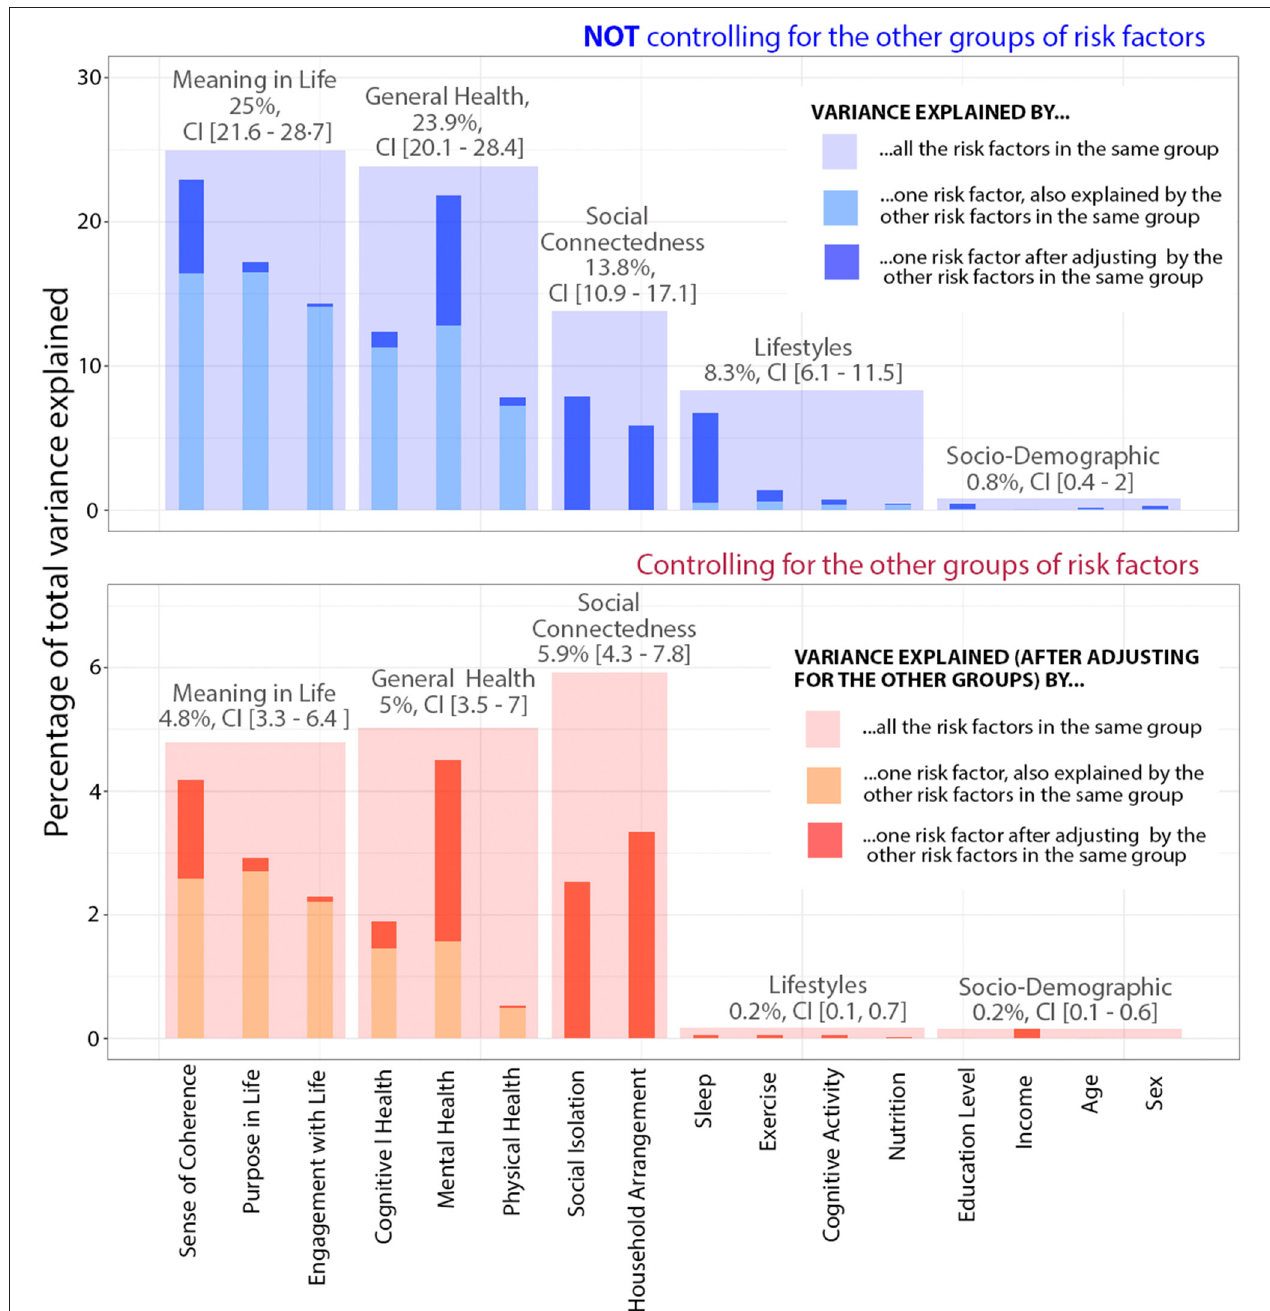
FIGURE 1 | Proportion of variability in loneliness explained by different risk factors in models with different number of controlling factors. The full model including all risk factors classified in five conceptually distinct groups (including 16 factors) was able to explain a total of 37.87% of the variability in loneliness levels [adjusted R 2 = 37.31%, CI (34.40%,